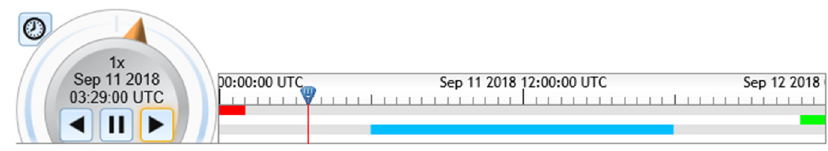
Figure 6. GeoView time control module.